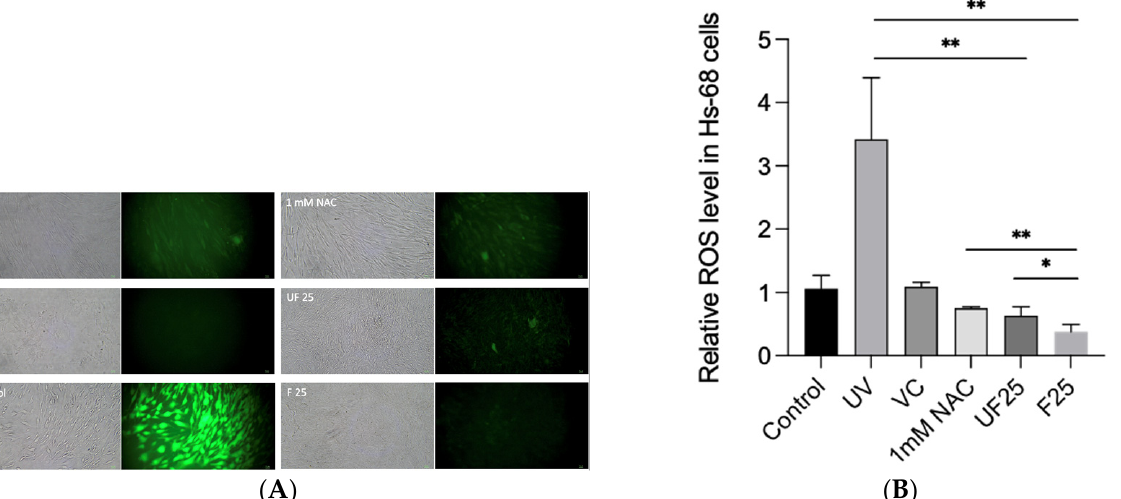
Figure 4. Effects of the fractions of fermented turmeric milk extract on UVA-induced ROS production and cell survival rate after UVA exposure in Hs68 cells. ( A ) Images of ROS production in Hs68 cells were observed under fluorescence microscopy (400 × magnification). ( B ) The fold change of mean fluorescence intensity of Hs68 cells. Experimental results were repeated in triplicate, and bar values are the mean ± standard deviation. Statistics were analyzed by t -test, * = p < 0.05, ** = p < 0.01. VC: Vehicle Control. NAC: N-acetylcysteine group. UF25: 25 ppm of unfermented turmeric milk